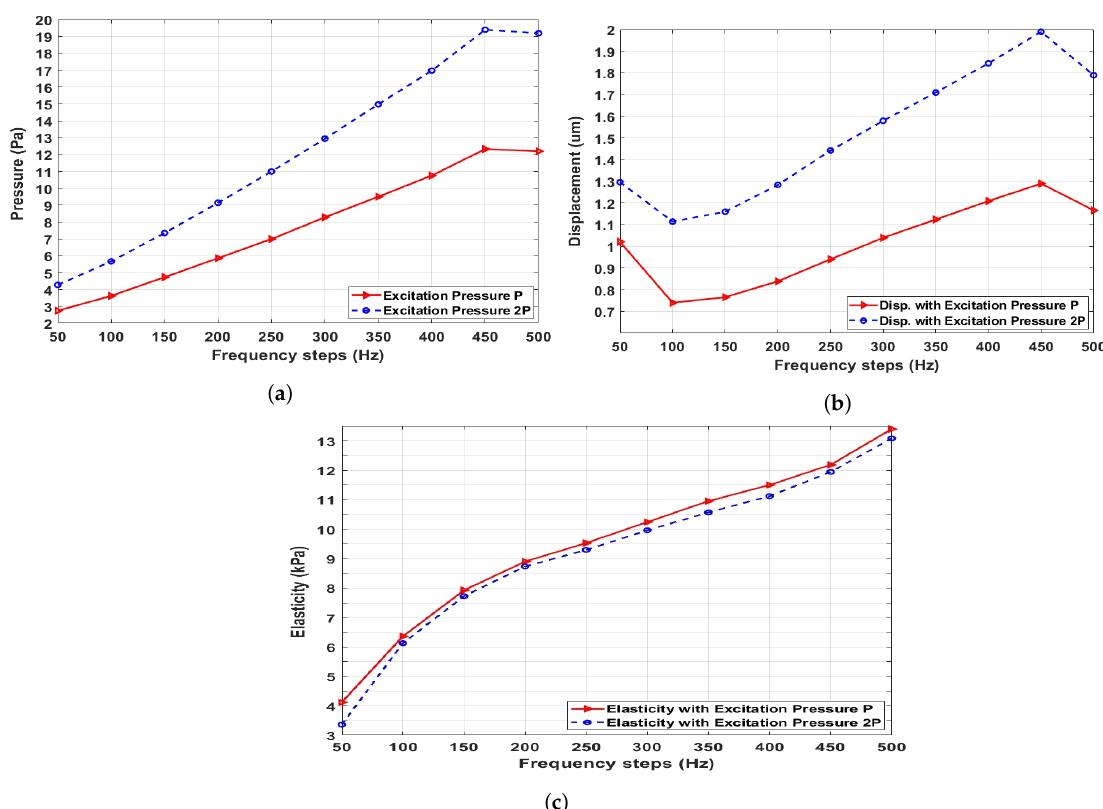
Figure 6. Influence of variation in the excitation pressure on the calculated modulus of elasticity; ( a ) disparate pressure amplitudes; ( b ) the measured displacement amplitude; ( c ) the modulus of elasticity of the two excitation ranges.